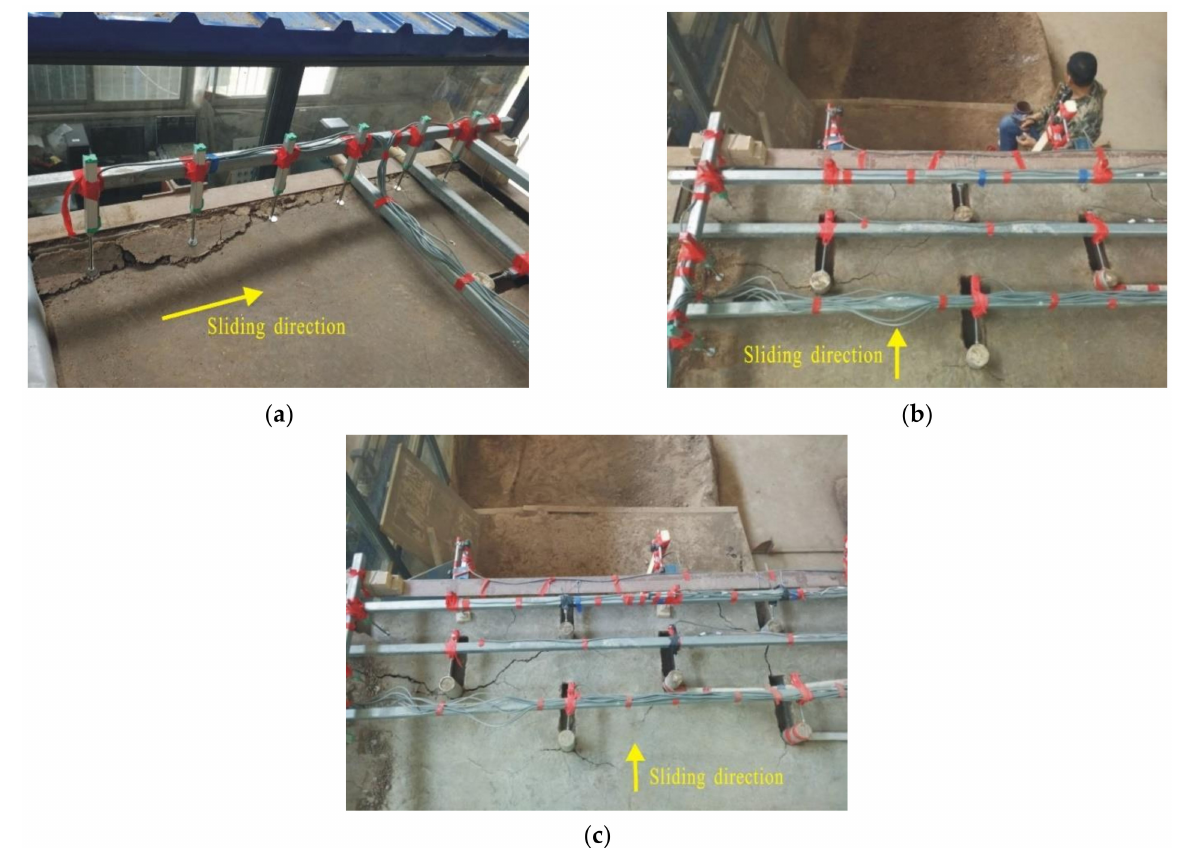
Figure 8. Deformation and damage of landslide: ( a ) settlement of slope top before loading; ( b ) crack in pile position before loading; ( c ) crack in pile position at the end of